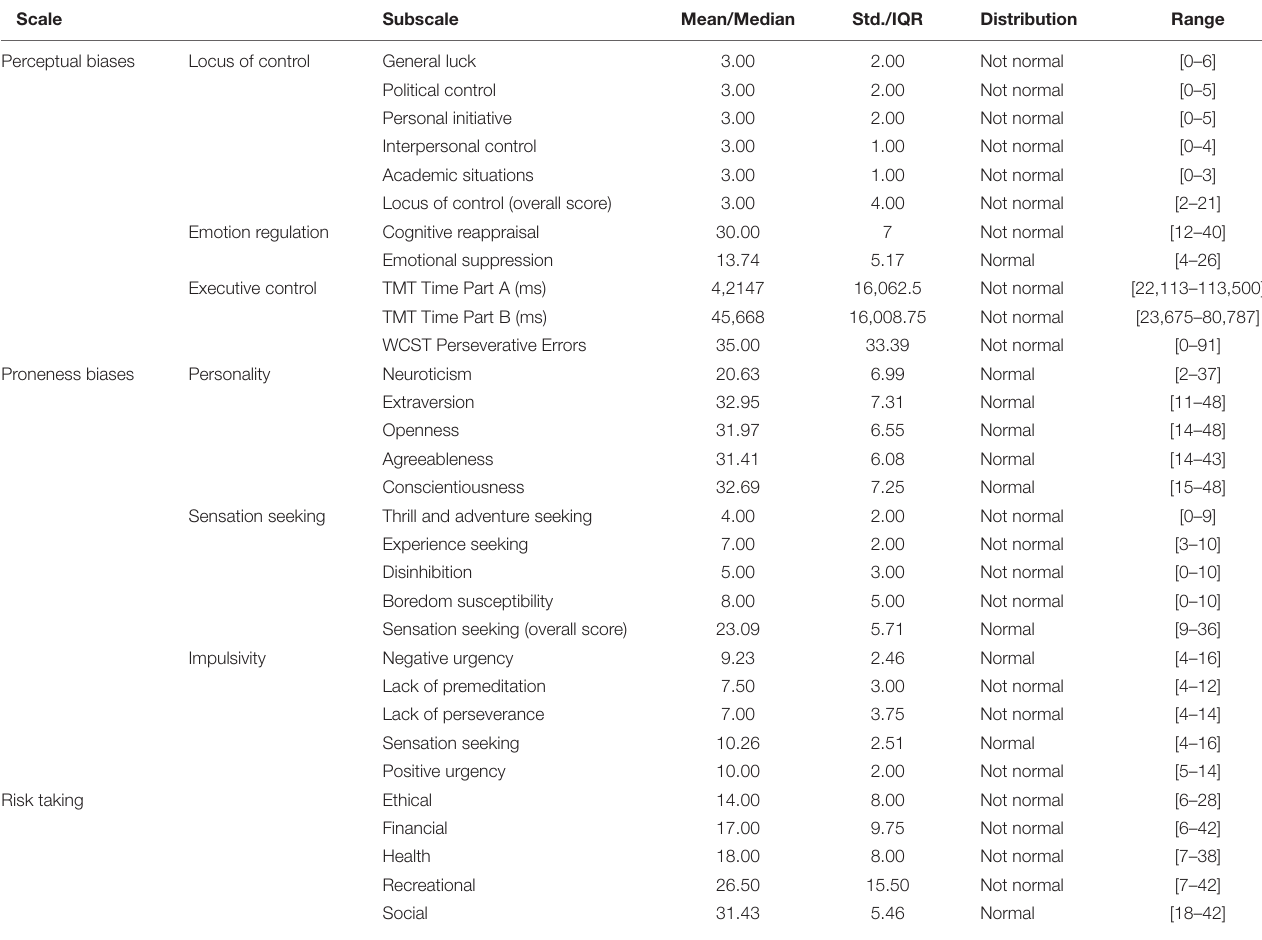
TABLE 1 | Descriptive analysis of all variables, organized by subscales. Scale Subscale Perceptual